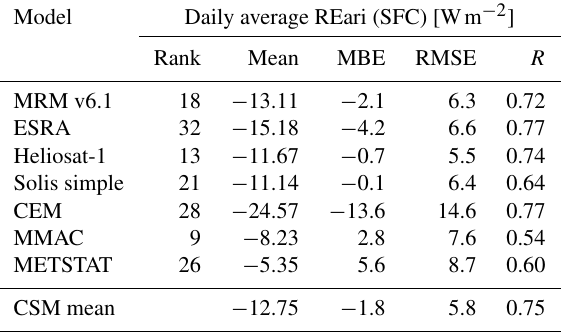
Table 9. Annual mean of daily average values of the surface REari. The REari is simulated and averaged over all DWD measurement stations using CSM. The CSMs are sorted by performance of REari versus the T–CARS method indicated by the MBE, RMSE and cor- relation. In addition, the performance rankings of clear-sky irradi- ance estimates of the individual CSM are shown as proposed by Sun et al. (2019).